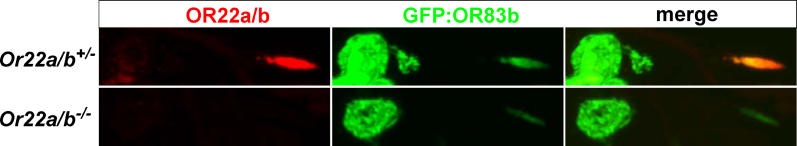
OR-Independent Localization of OR83b to OSN Ciliated DendritesImmunostaining for OR22a/b (red) and GFP:OR83b (α-GFP, green) in antennal sections of control heterozygous (Or22a/bΔhalo/+;Or22a-Gal4/UAS-GFP:Or83b, top panels) and homozygous (Or22a/bΔhalo/Or22a/bΔhalo;Or22a-Gal4/UAS-GFP:Or83b, bottom panels) Or22a/b null-mutant animals. Images of control and mutant samples were taken at identical confocal settings to permit comparison of signal intensities.